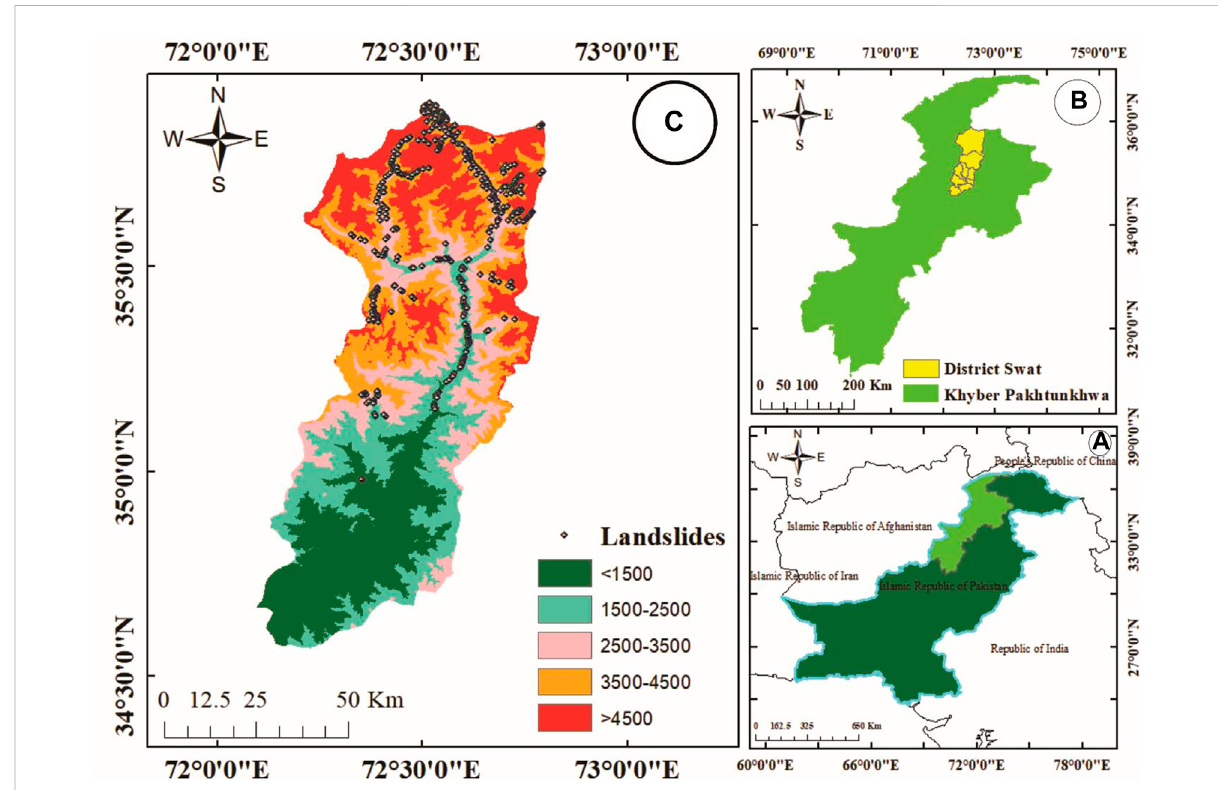
FIGURE 1 Map of the study area along with elevation in meters and spatial location of landslide events: (A) Pakistan administrative boundaries of KPK province; (B) Swat District in KPK shape fi le; (C) elevation and landslide inventory of study